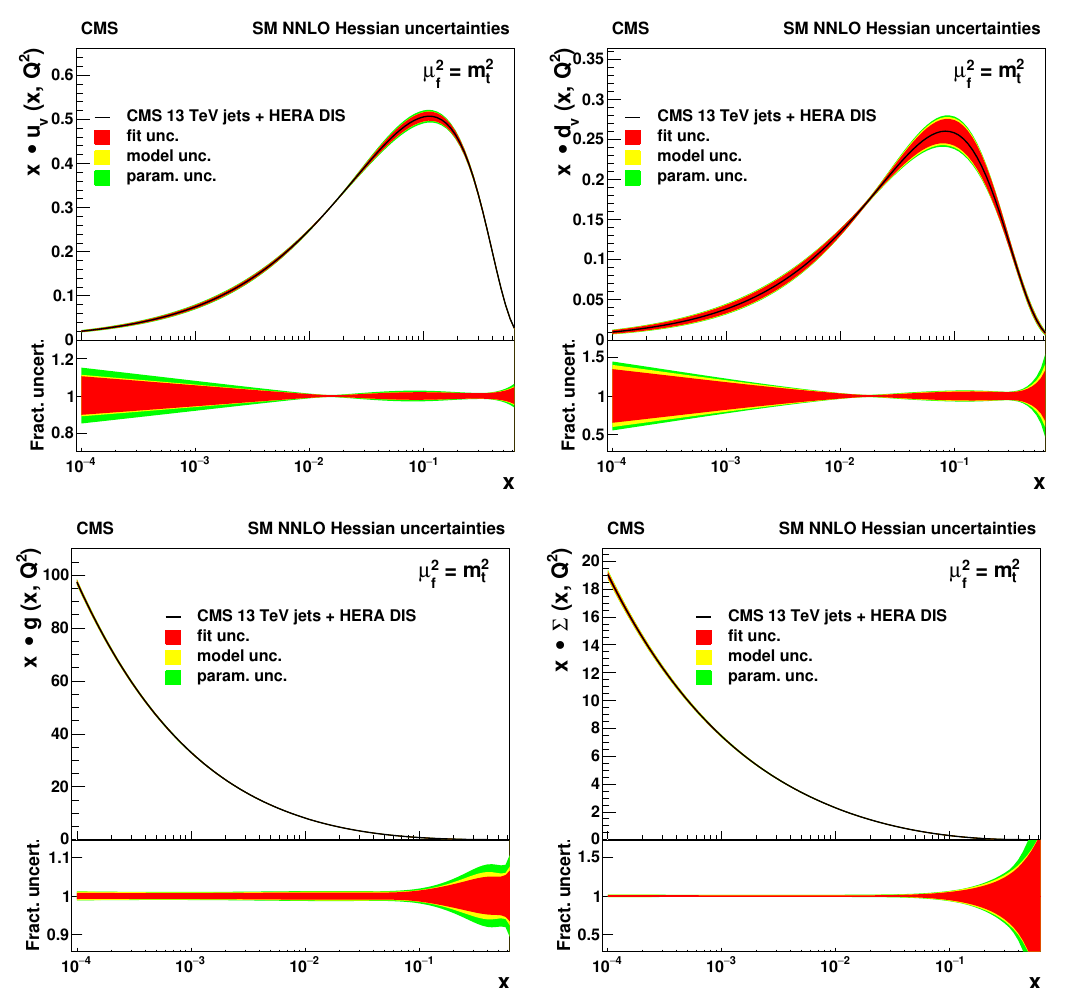
= m 2 , resulting from the f t √ s = 13 TeV.